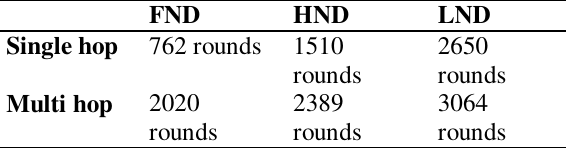
Fig. 6. Total dead node of the system against transmission rounds for single hop and multi hop protocols Dead nodes for Single hop and Multi hop